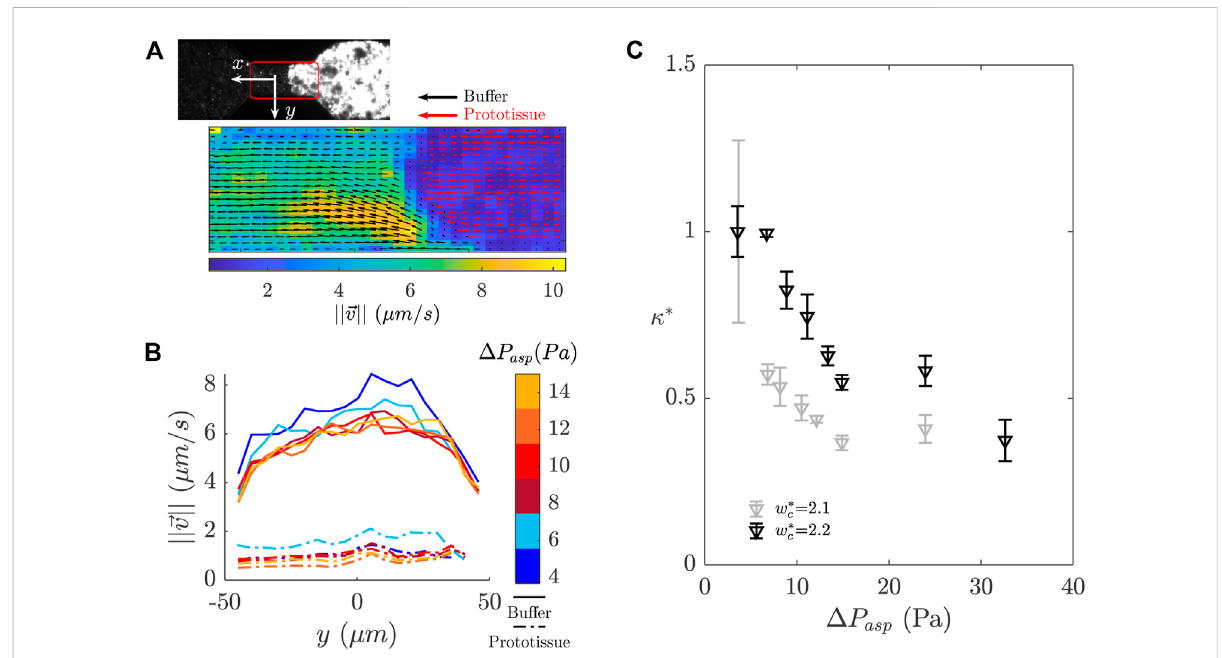
FIGURE 6 Particleimagevelocimetry(PIV)analysisperformedinthemicro fl uidicconstrictionduringtheprototissueaspirationsequence. (A) De fi nitionof the region of interest for PIV analysis (175µm×100 µm area). The colormap corresponds to the velocity magnitude. The red and black arrows show the velocity vectors of the prototissue and the buffer respectively in different scales. (B) Velocity pro fi le along the y axis (orthogonal to the fl ow direction). Thevelocitypro fi leswereaveragedintime overthesteady stateregimeandalongthe x axis(forboththeprototissueandthebuffer). The colormap represents the corresponding pressure values. (C) Plot of the relative permeability κ * as a function of Δ P asp for prototissues with 4%- biotin